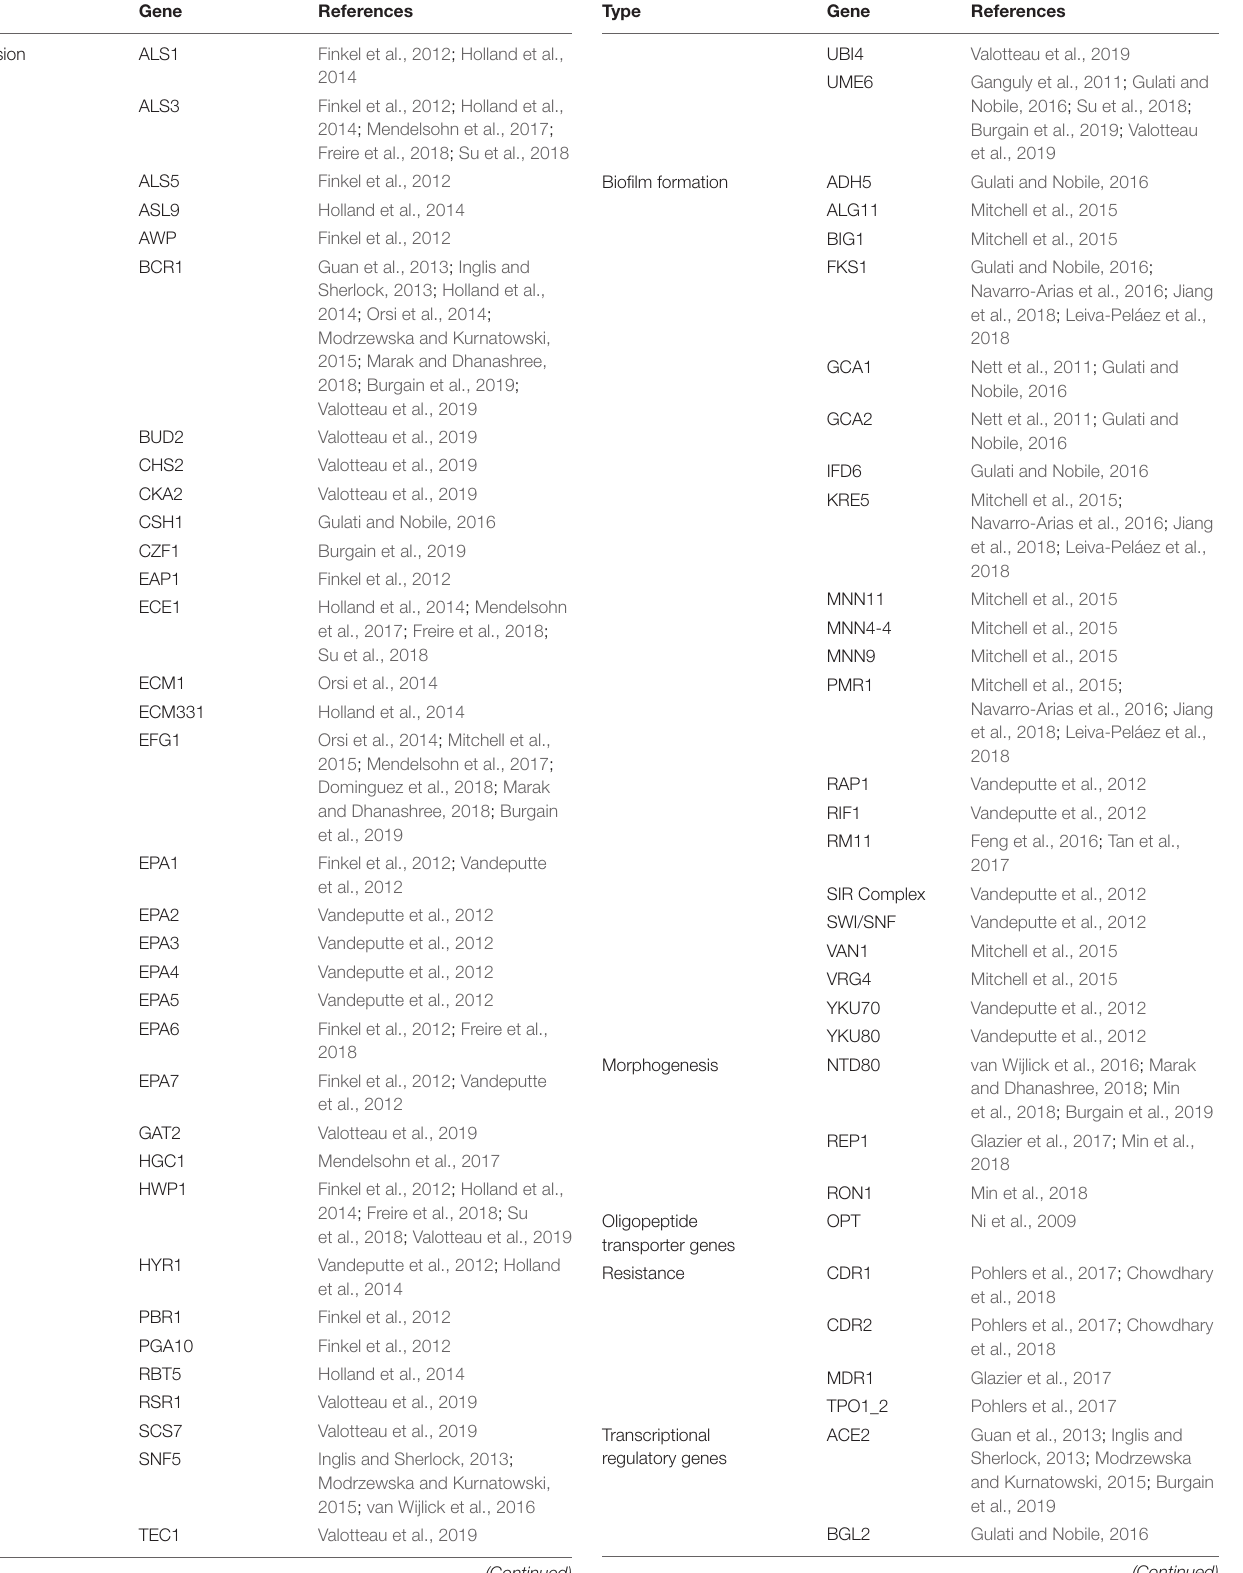
TABLE 1 | The main genes involved in biofilm formation in Candida